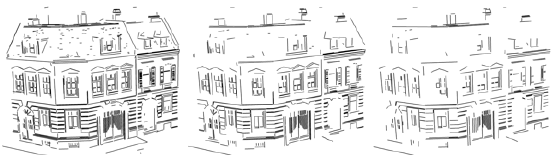
Figure 2. Line3D++ performance examples for DTU-006 dataset using different visibility threshold values ( v=5,8,11 images) and pixel error p=1 . The stricter the visibility threshold, the fewer the reconstructed lines in 3D (respectively 2486, 1428, and 860 line segments).